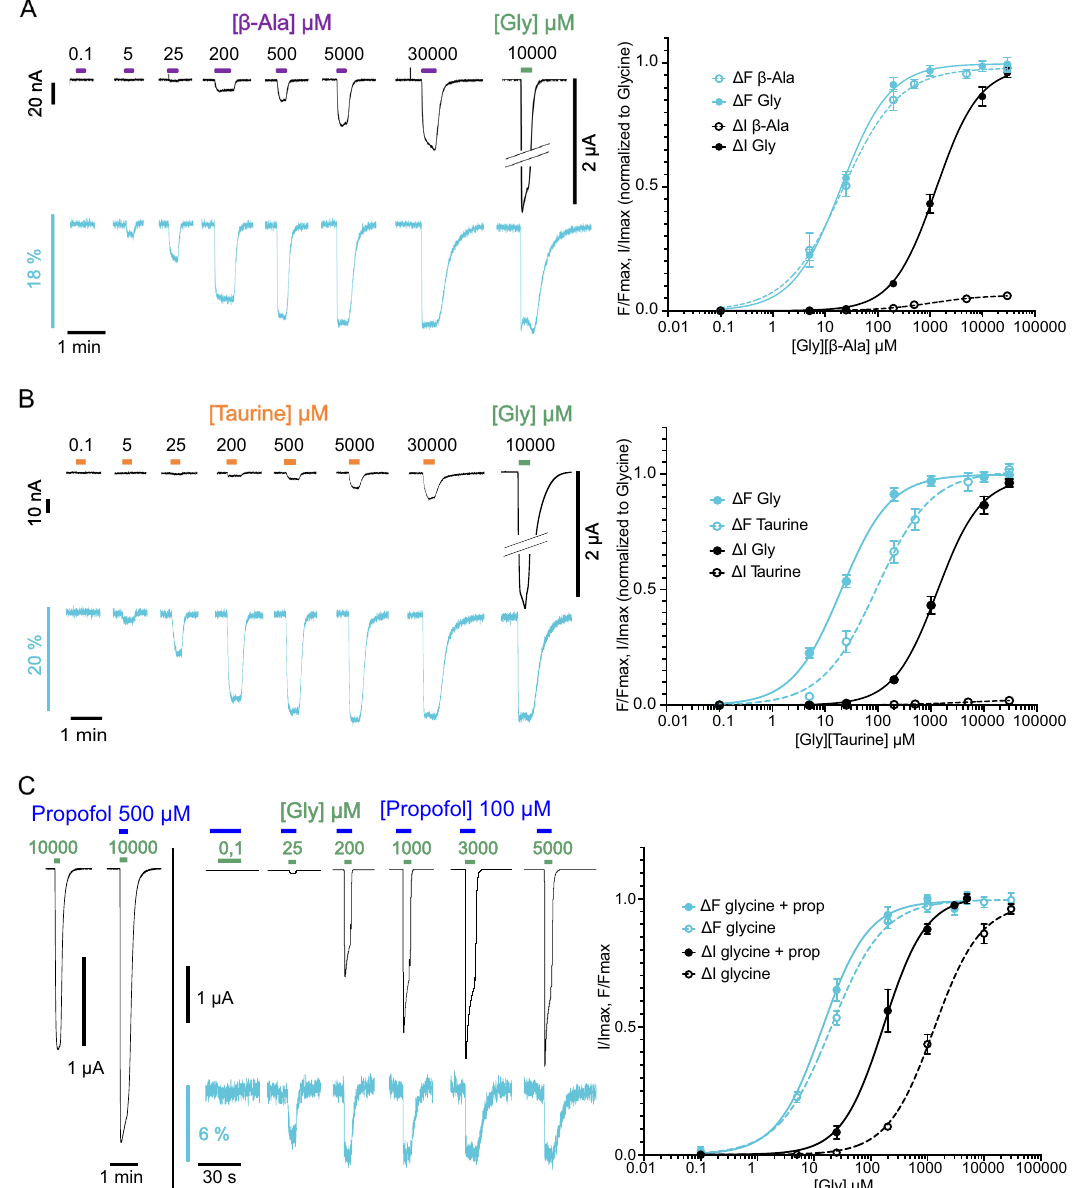
Fig. 4 | Electrophysiological and fl uorescence characterization of partial- agonist ( β -alanine and taurine) and propofol effects on K143W/Q219C sensor on C41V GlyR. A Right panel: Representative VCF recordings on an oocyte chal- lengedwithboth β -alanineandglycine.Leftpanel:representativeVCFrecordingon oocytes under the β -alanine application. Right panels: the Δ I (cyan) and Δ F (black) curves (normalized to the glycine maximal response recorded on each individual oocyte) with mean and SEM for K143W/Q219C under glycine (solid line) and β - alanine (dotted line) application. The Δ F curves for both molecules are super- imposed but the ef fi cacy of β -alanine to activate the receptor is lower than that of glycine (6.1±2.2% of glycine maximum response in current, n =6). B Right panel: Representative VCF recordings on an oocyte challenged with both taurine and